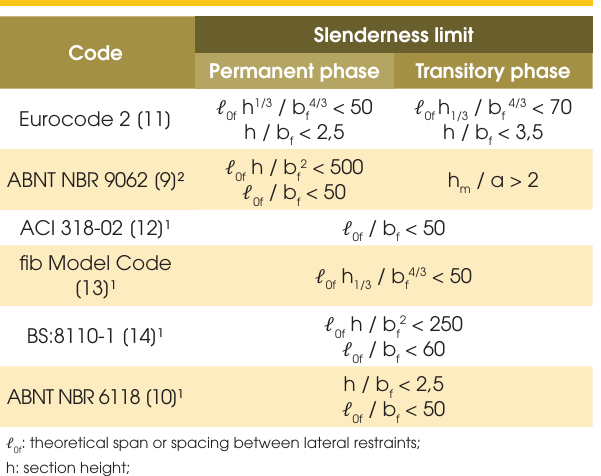
Table 1 – Code recommendations for lateral